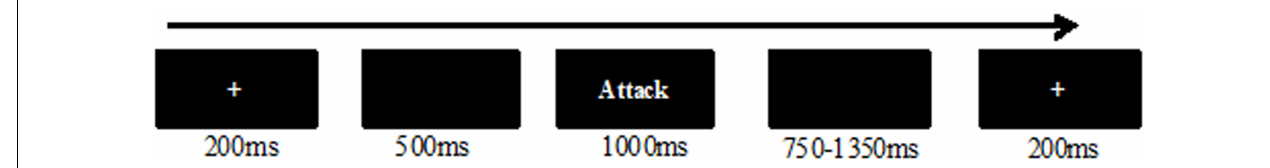
FIGURE 1 | Lexical decision task trial